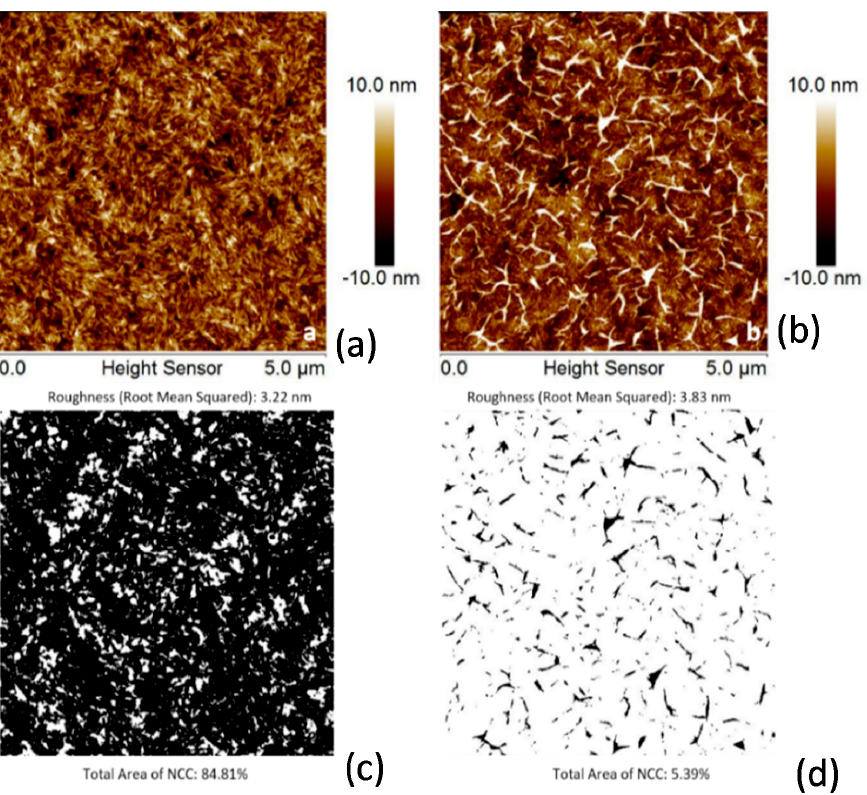
Figure 7. AFM images NCC coatings on PET as-deposited ( a , c ) and after rinsing in water ( b , d ): topography images ( a , b ) and flooding analysis images showing the surface coverage by NCC particles ( c , d ).